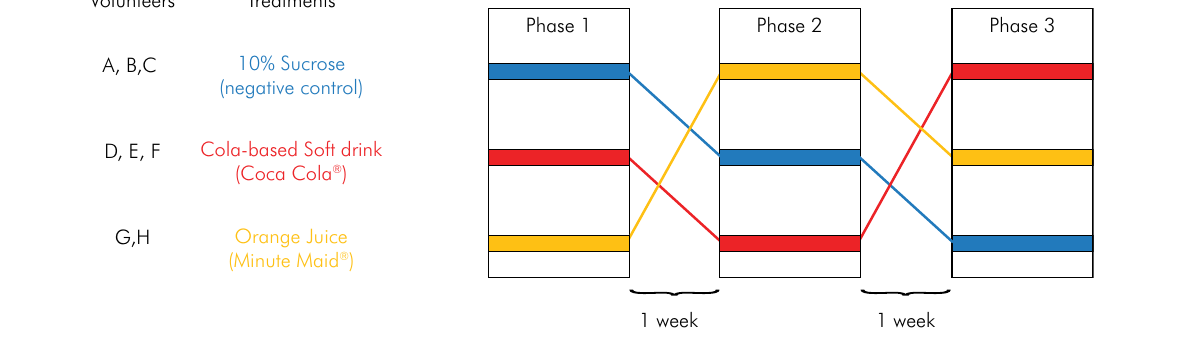
Figure 1. Schematic representation of the experimental design.